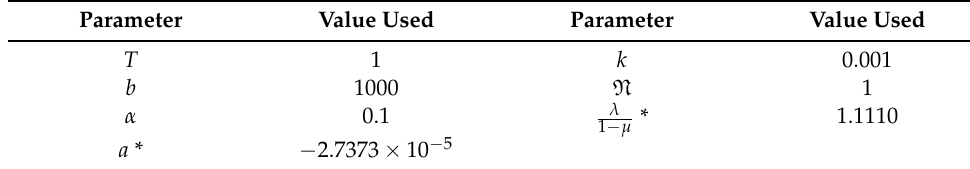
Table 6. Acquisition parameters for Amazon stock.